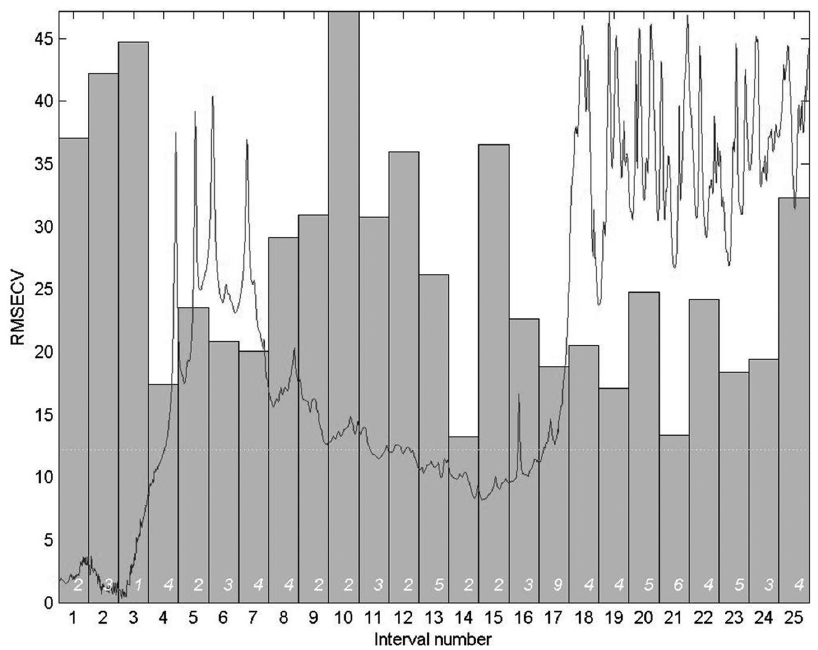
Figure 5 - Cross-Validated Prediction Errors (RMSECV) values for full-spectrum model and interval models (bars) for the TMP determination using PLS and iPLS algorithms (dotted line and numbers above interval numbers refer to full-spectrum RMSECV and latent variables used in each model, respectively).